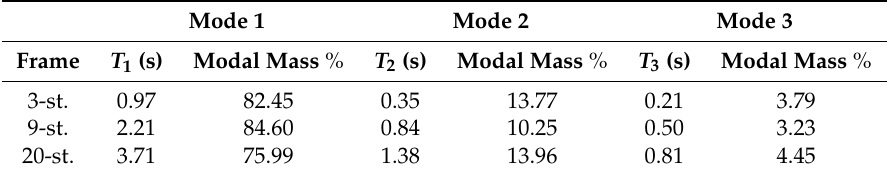
Table 1. Modal properties of the frame